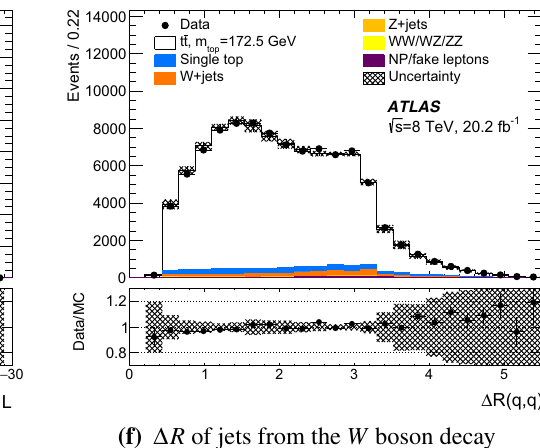
ton, b shows the average transverse momentum of the jets, c shows the transverse momentum of the hadronically decaying top quark, d shows the transverse momentum of the t ¯ t system, e shows the logarithm of the event likelihood of the best permutation and f shows the distance (cid:10) R of the two untagged jets q 1 and q 2 from the hadronically decaying W